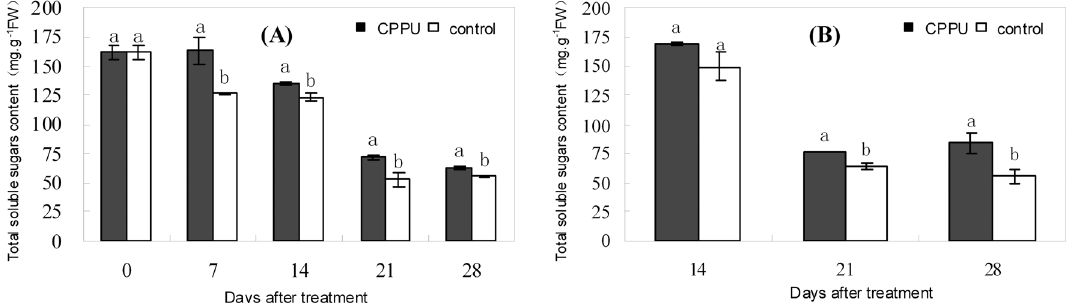
Fig 3. Effect of raceme soaking with CPPU on the total soluble sugar content in the husk (A) and seed (B). Different letters indicate significant difference between the treatment and the control based on t -test ( p < 0.05).